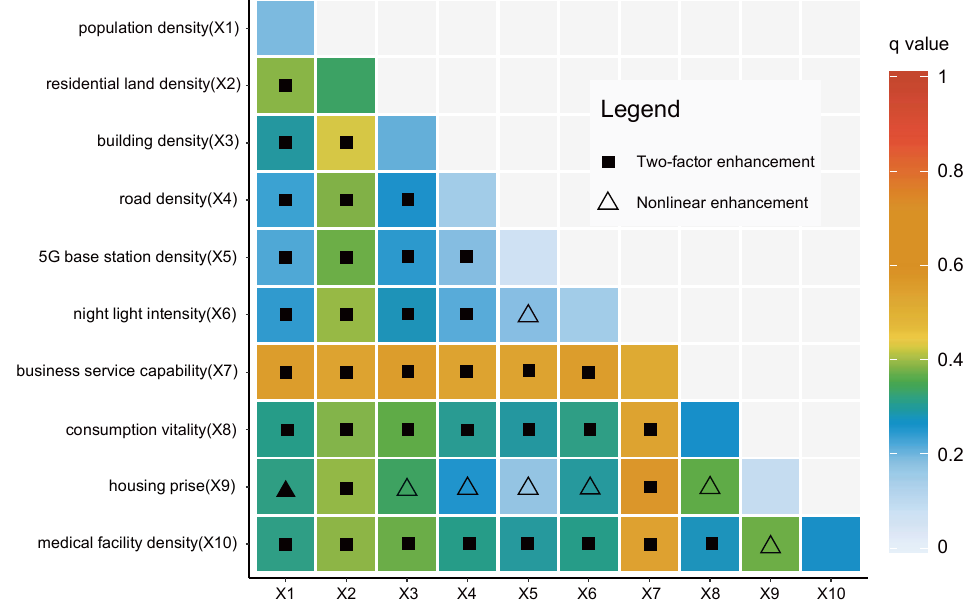
Figure 6. The interaction detection results of spatial pattern of unmanned aerial vehicle (UAV) logistics network in Hangzhou.